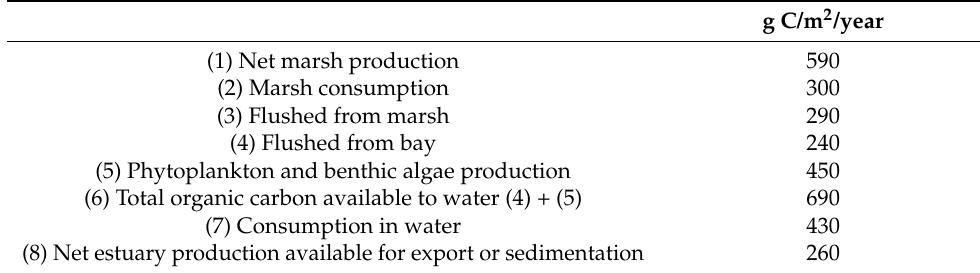
Table 5. Metabolic measurements and estimates for Barataria Bay (modified from [66]; data collected November 1971 to November